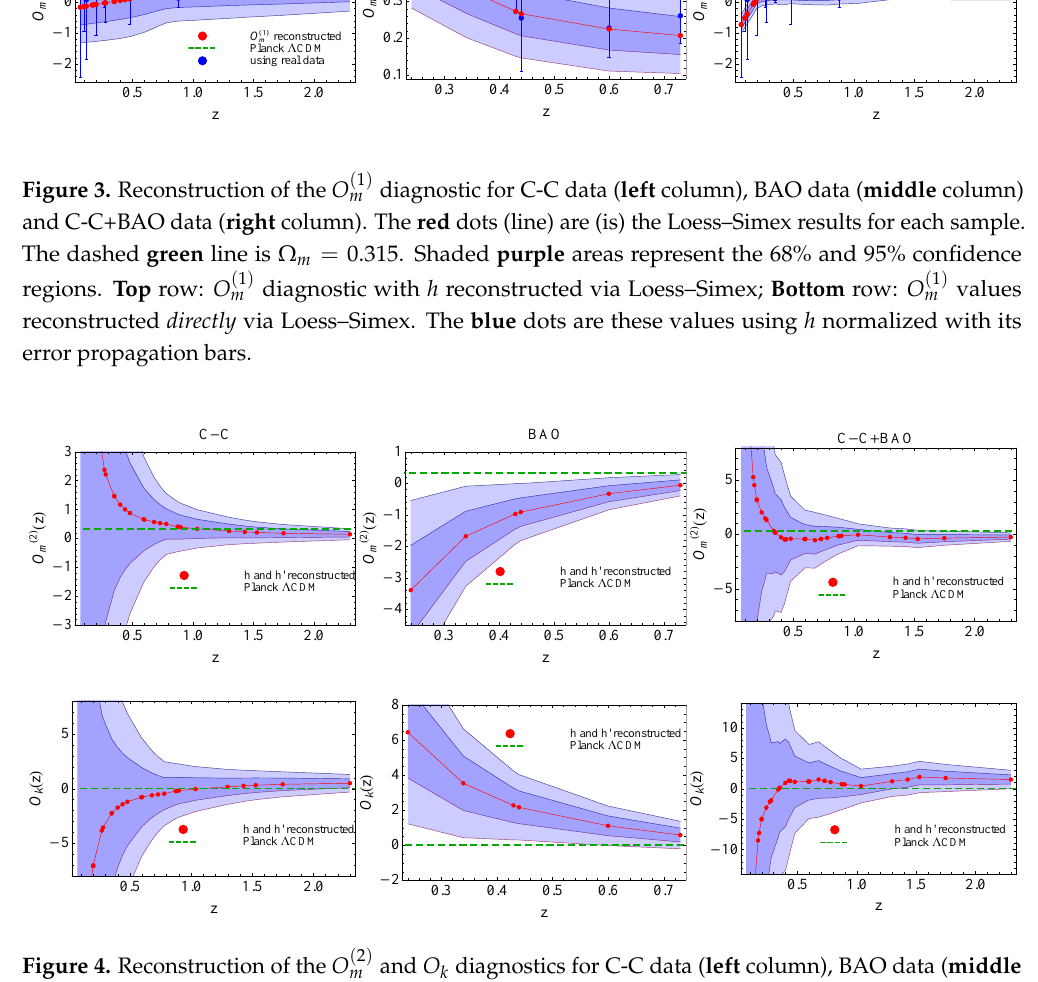
( 2 ) m ( 2 ) m diagnostic with